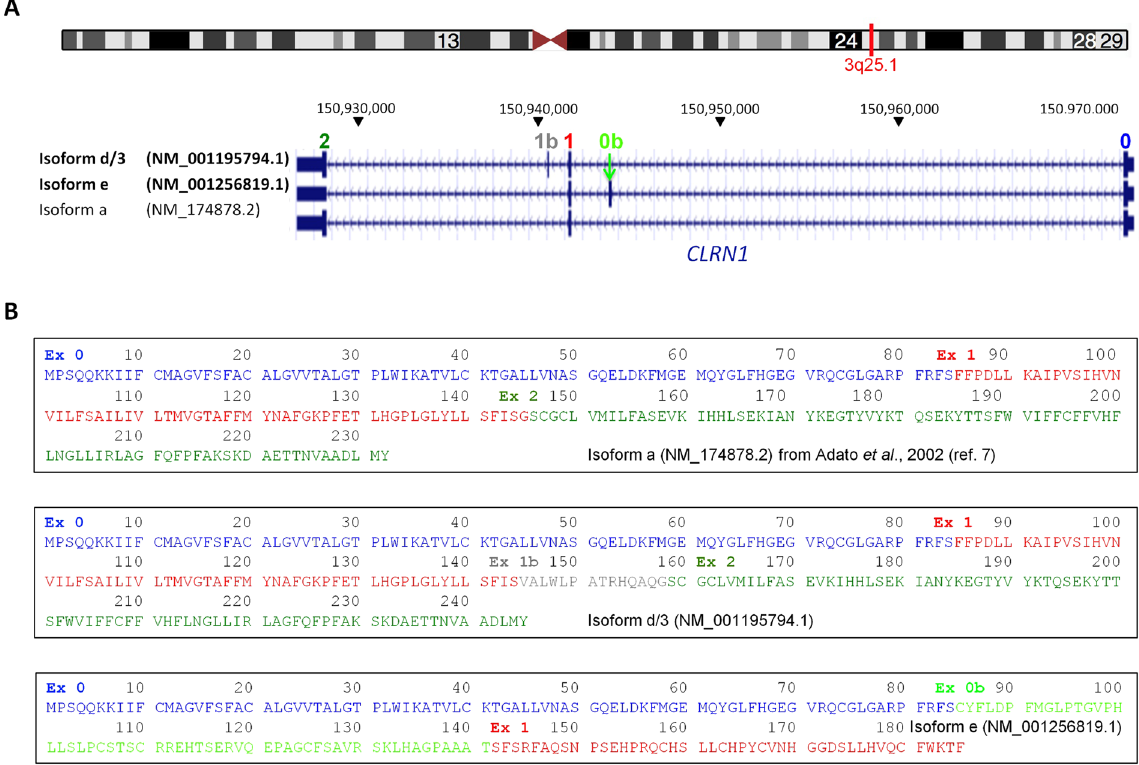
Figure 2. Scheme of UCSC-annotated Refseq CLRN1 isoforms (hg38). ( A ) For our construct, we refer to a combination of isoforms d/3 (NM_001195794.1) and e (NM_001256819.1) that also includes the exons of the “major isoform”, isoform a (NM_174878.2) 8 : exons 0, 1 and 2. We designated additional exons, which are located between exons 0 and exon 1 and between exons 1 and exon 2, respectively, as exon 0b and exon 1b. ( B ) Protein sequences of the three above isoforms. In NM_001256819.1, the inclusion of exon 0b shifts the reading frame of exon 1, resulting in a different peptide sequence for exon 1 in this isoform. Note that, in contrast to the scheme in Fig. 3, the isoforms are in antisense